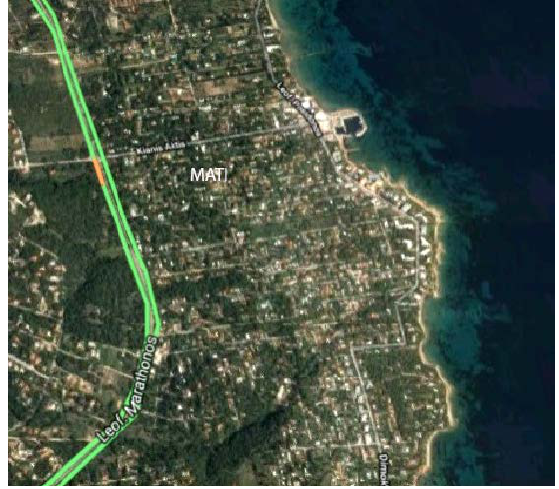
Figure 2. Satellite picture of Mati before the fire occurrence (from Google Maps).